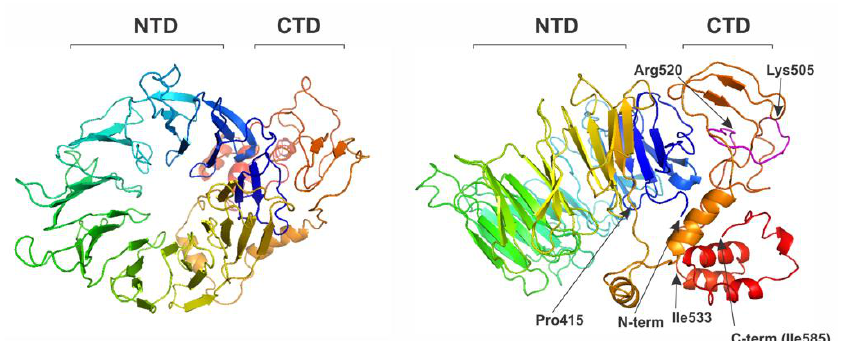
Figure 4. Predicted structure of the human eIF2A protein, showing top view (left) and side view (right) of the β -propeller domain. N-terminal domain (NTD) (residues 1-415) folds into 9-bladed β -propeller. The C-terminal domain (CTD) is less structured and may consist of two to three smaller subdomains (with very C-terminal fragment residues 533-585 represented by a helix bundle). Residues 505–520 (in magenta on the right image) represent a potential PEST motif. Homology modeling was done using Phyre2 Protein Fold Recognition Server.